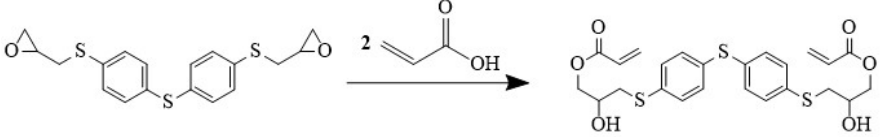
Figure 3. Synthesis of EA-UV photopolymer.